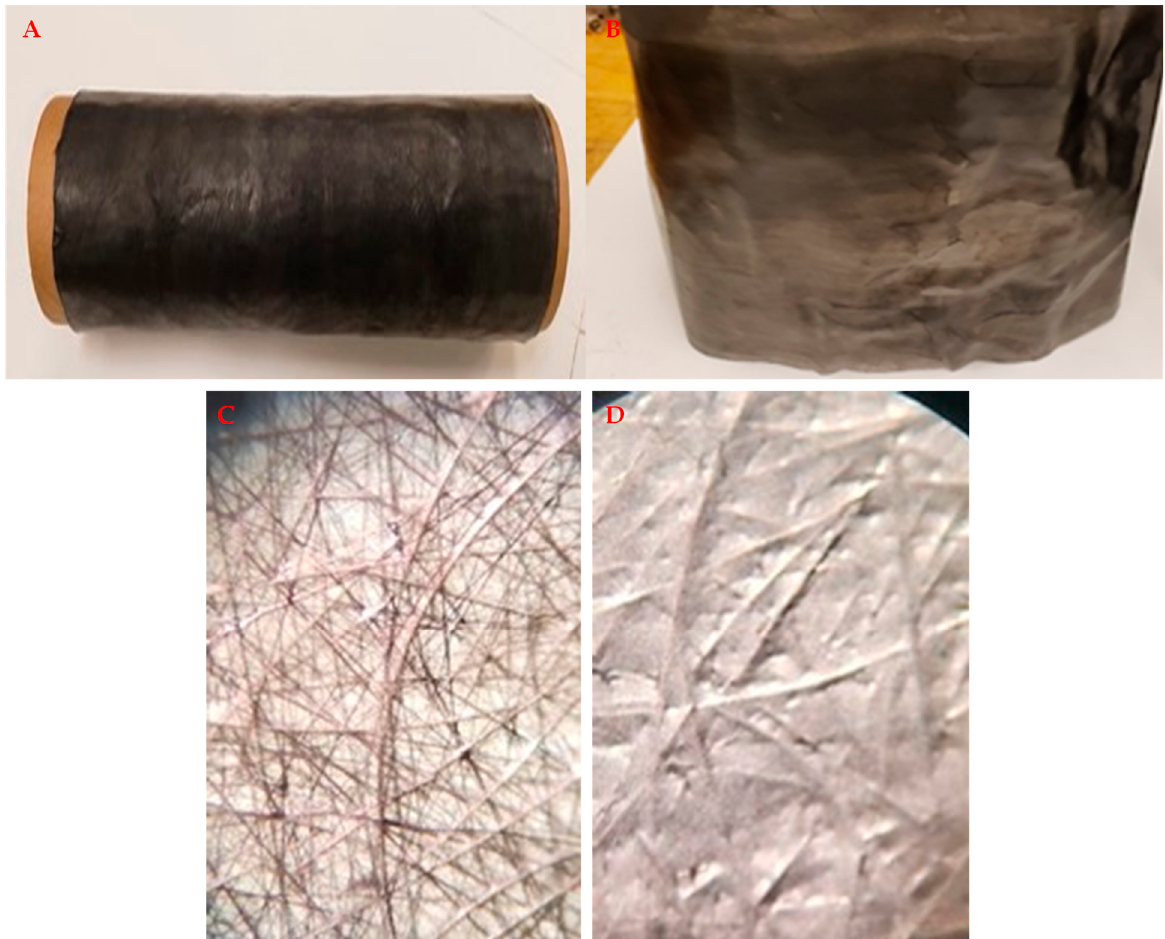
Figure 11. Tissue/CNT fabric. ( A , B ) Formed by layering thin CNT onto carbon fiber tissue. A drum of tissue-CNT is opened and wrapped on a spool. This material is used for filtering applications. ( C ) CNT filter fabric, showing the tissue side, where tissue/CNT is partly transparent. ( D ) Showing the CNT side for the tissue/CNT fabric.